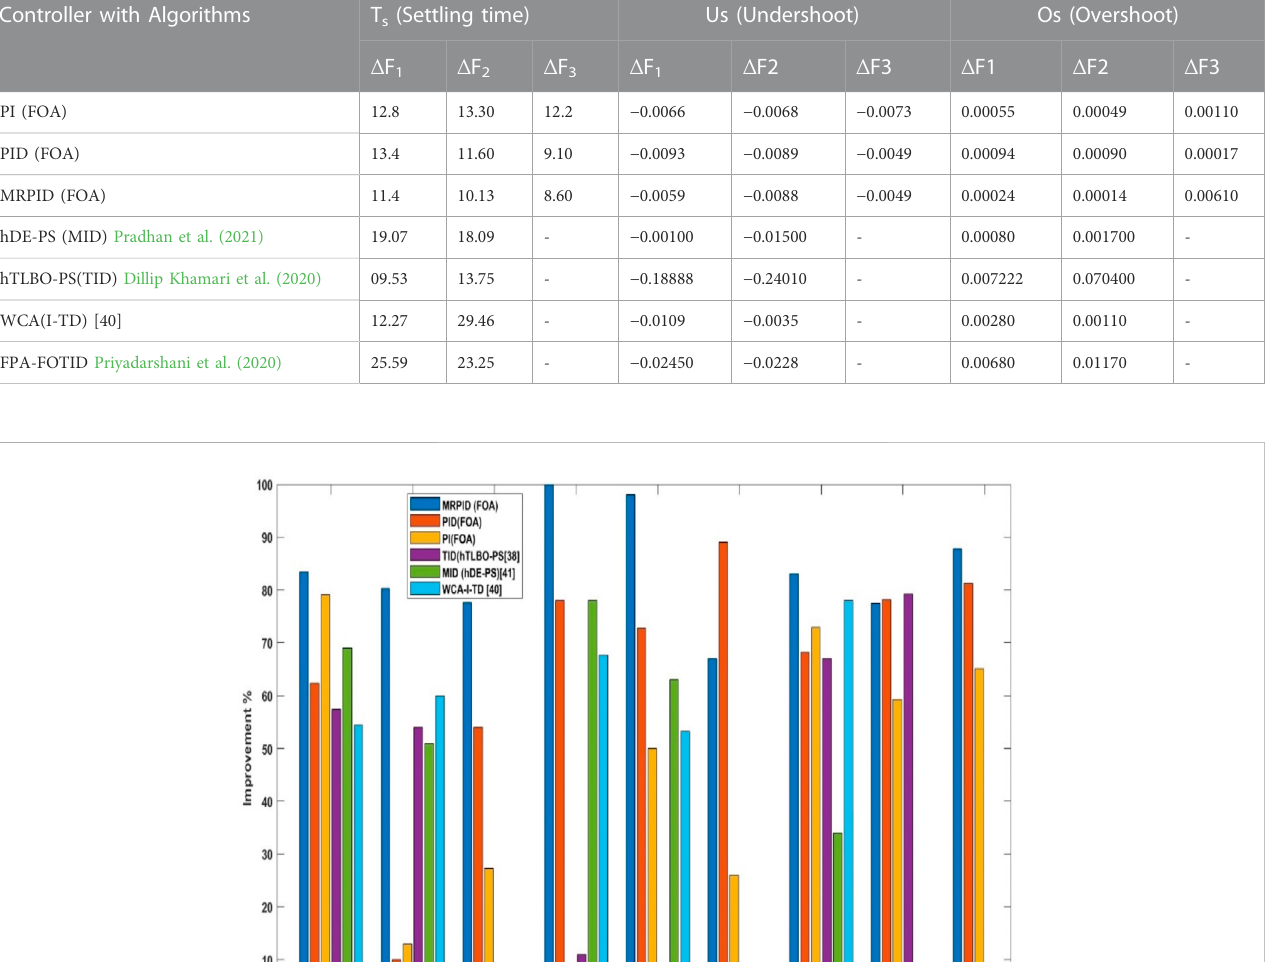
TABLE 3 Controller with algorithm for three area interconnected power system. Controller with Algorithms